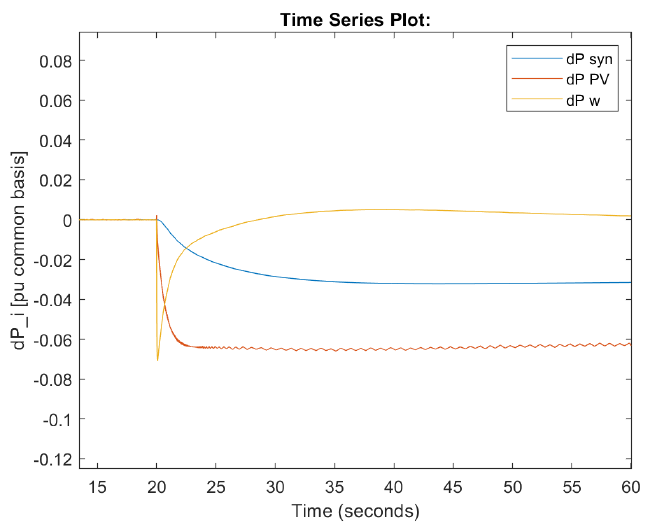
Figure 25. Simulation 18 power variations.